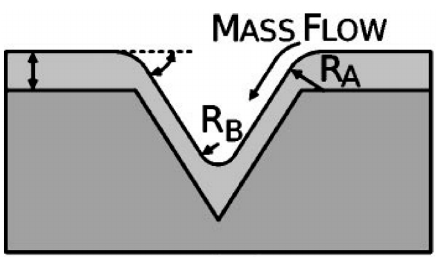
Figure 14. Schematic picture of a conformal film of thickness d deposited on a patterned substrate. The scheme indicates the curvature at the pit edge, R A , and at the inverted apex, R B . The film will evolve to minimize these local curvatures by atomic diffusion from A to B. Reproduced from [48] with permission from the American Institute of Physics.